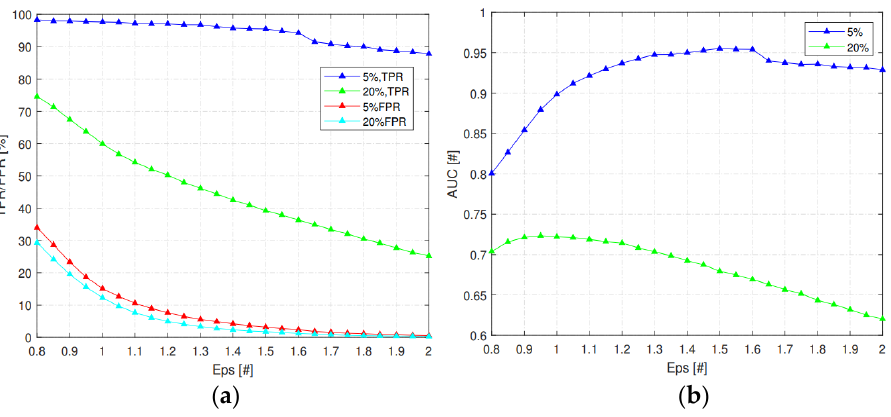
Figure 9. ( a ) The effects of Eps on TPR and FPR; ( b ) The effects of Eps on AUC.